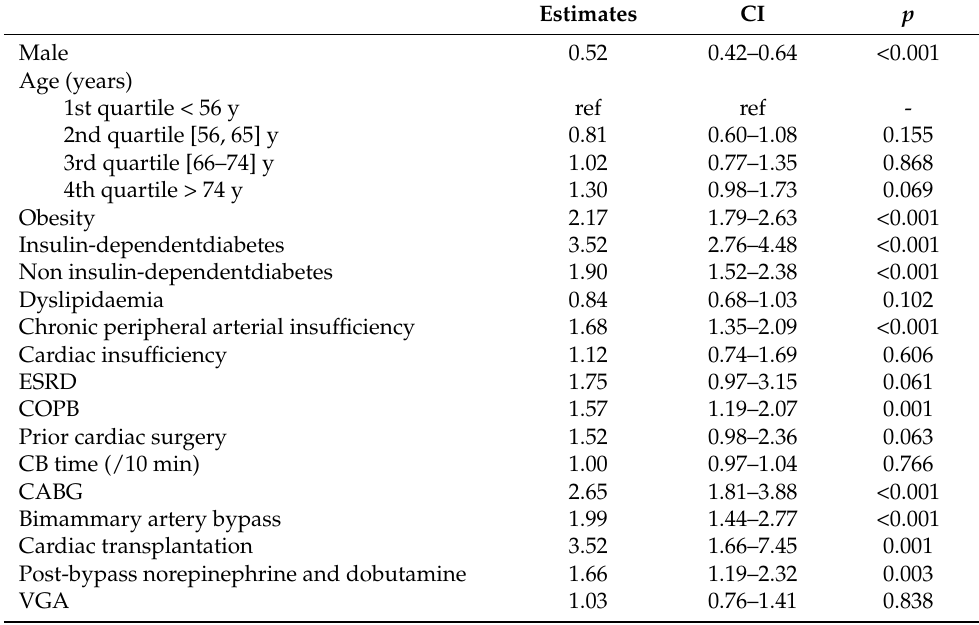
Figure 4. SSI-free patients at 90 days and delay of SSI occurrence according to the type of prophylaxis in the sensitivity analysis, excluding infective active endocarditis. ( A ) All SSI, ( B ) Superficial SSI; ( C ) Deep SSI. CA, cephalosporin antibiotic prophylaxis; VGA, vancomycin/gentamicin antibiotic prophylaxis; SSI, surgical site infection. Table 5. Multivariate analysis of risk factors for SSI in a sensitivity analysis, excluding